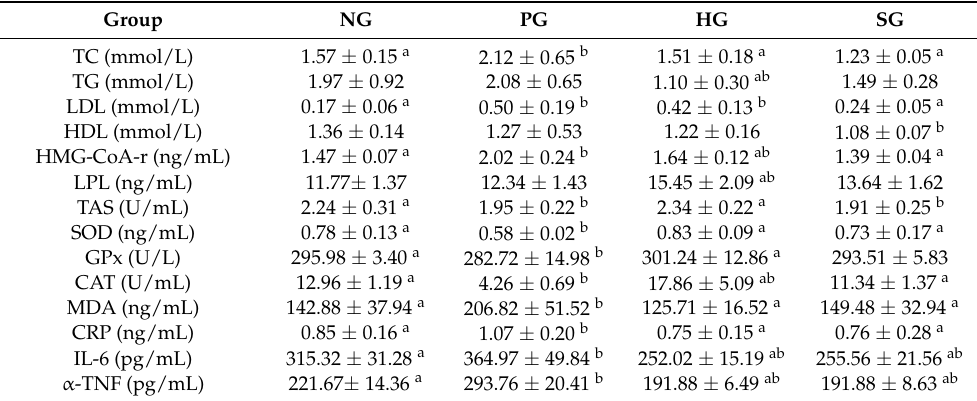
Table 4. The beneficial effects of DPO treatment diet on hypercholesterolemic rats.